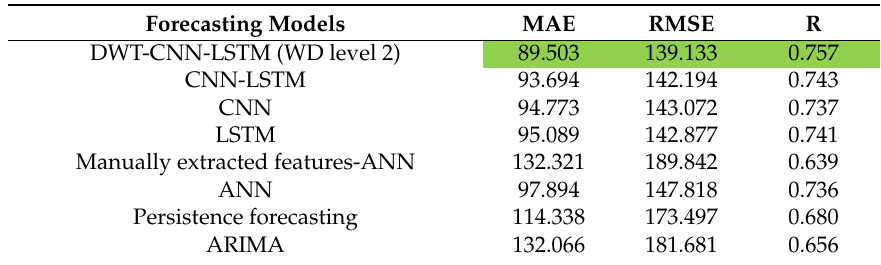
Table 12. The performance comparison of different rainy days’ forecasting models using the dataset of Elizabeth City State University.